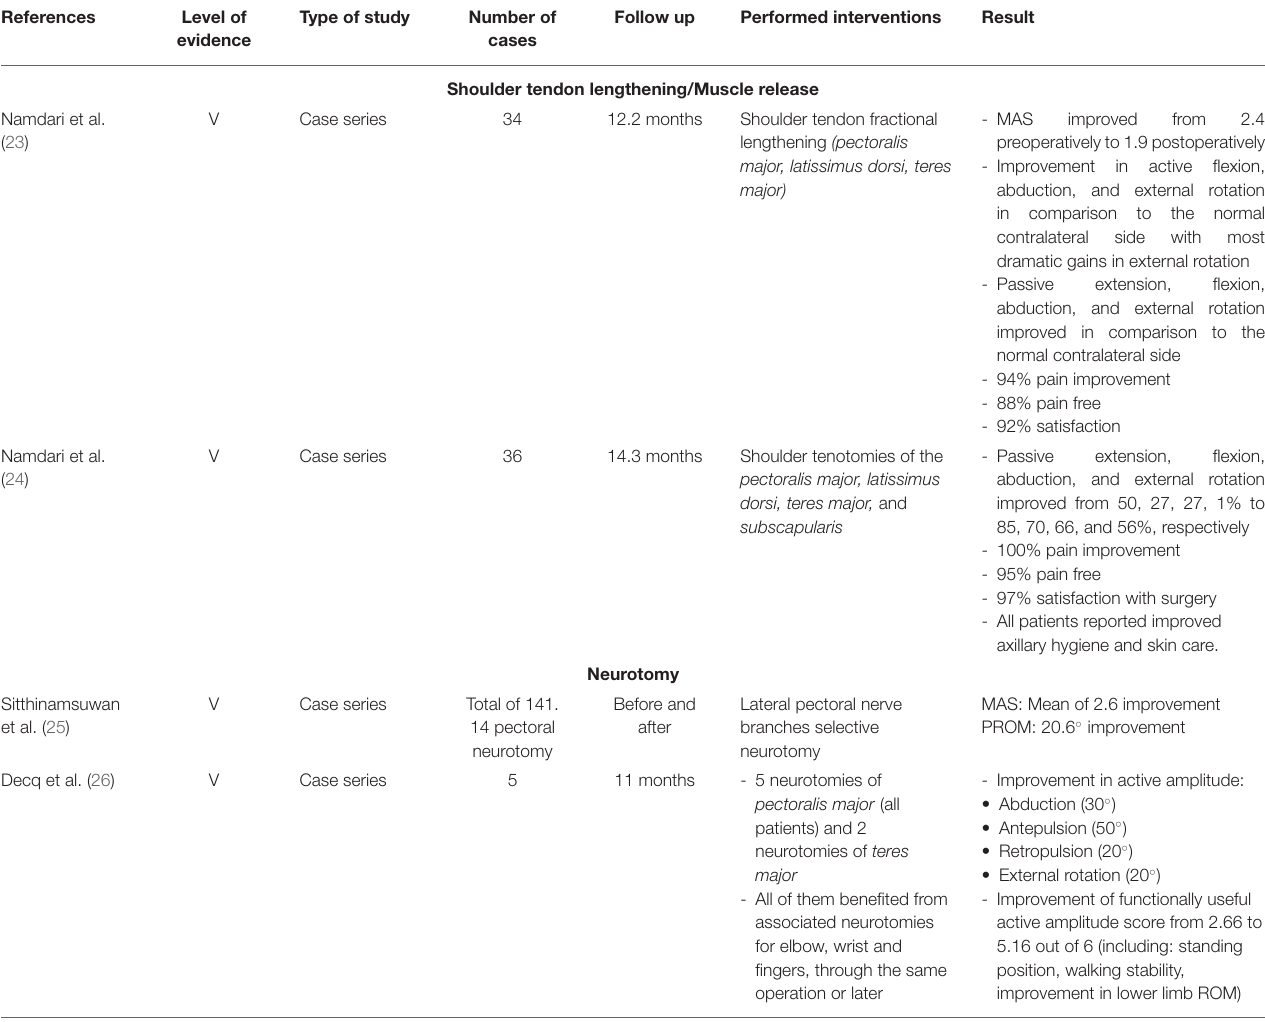
TABLE 1 | Summary of articles for surgical approaches to a spastic